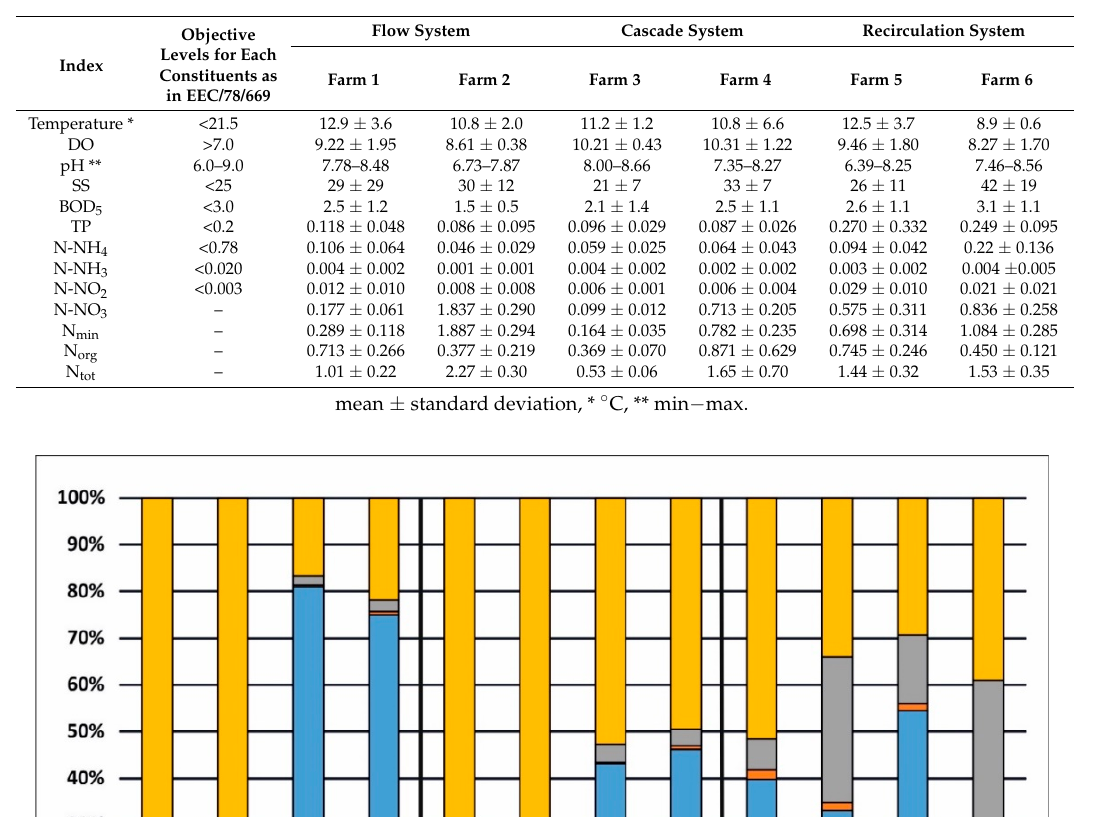
Table 2. pH value and mean concentrations of selected substances in waters inflowing to the analyzed fish farms (mg · dm − 3 ).